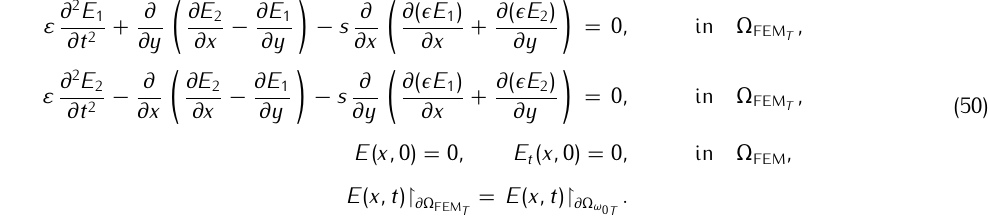
; c) at the FEM . We FEM